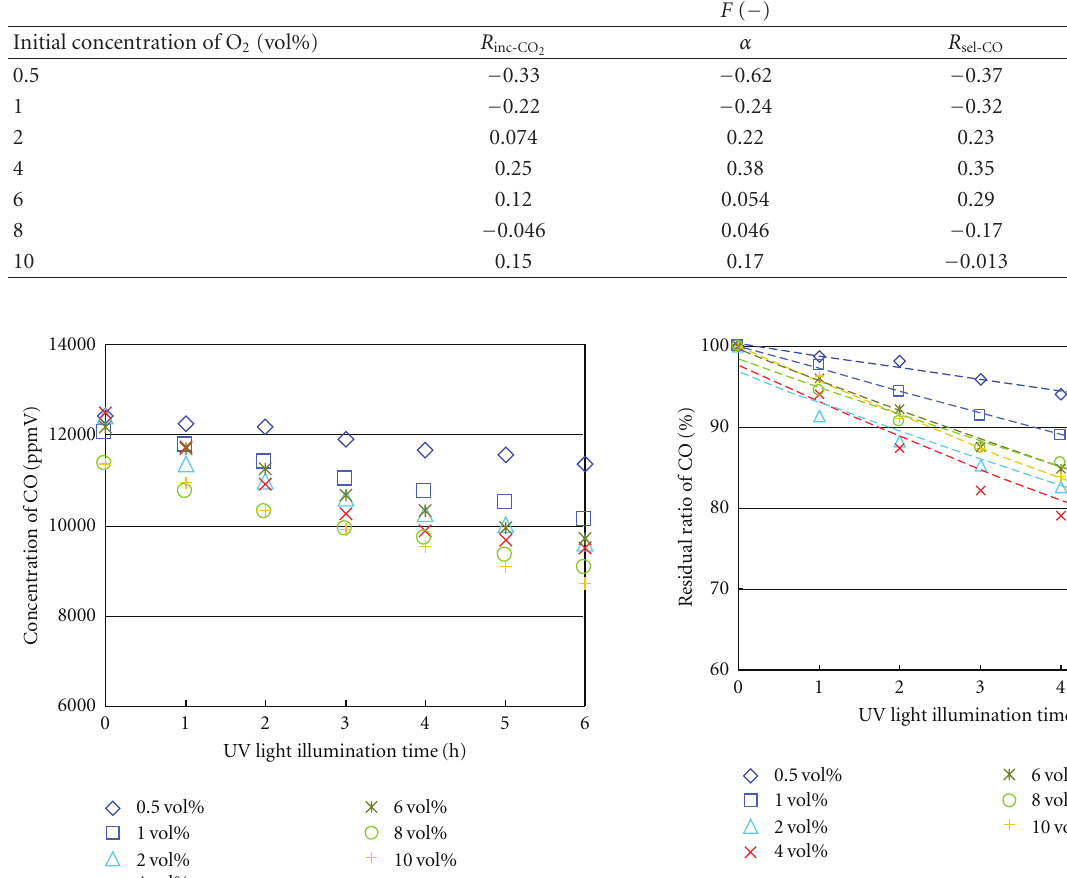
Figure 11: Residual ratio of CO for di ff erent initial concentrations of O 2